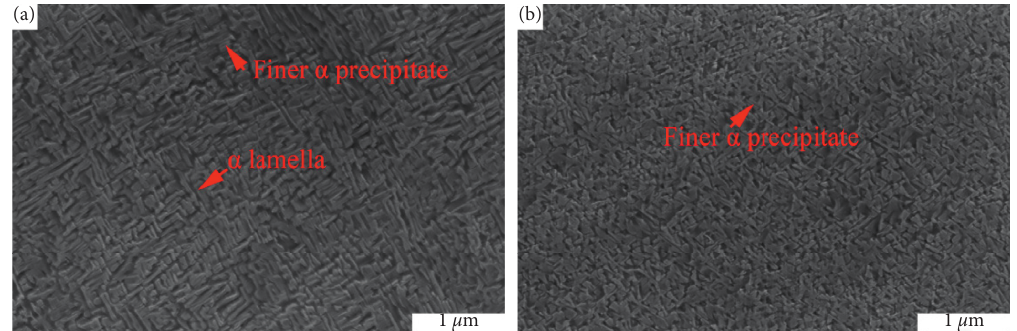
Figure 9: Thermal field emission SEM in recrystallized ß grains of (a) specimens rapidly heated to 860 ° C and (b) specimens rapidly heated to 925 ° C followed by ageing.